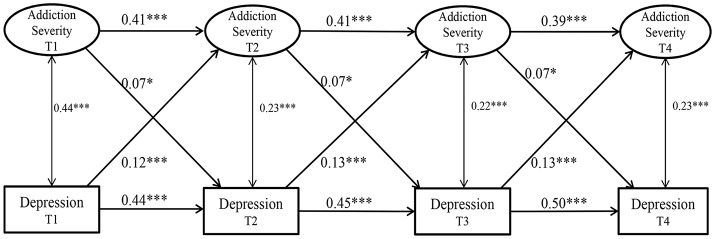
The cross-lagged regression analysis. We indicate the metric invariance, configural invariance, and invariance of error covariance across time using letters on the paths. The numbers are standardized path coefficients (*P < 0.05; ***P < 0.001).